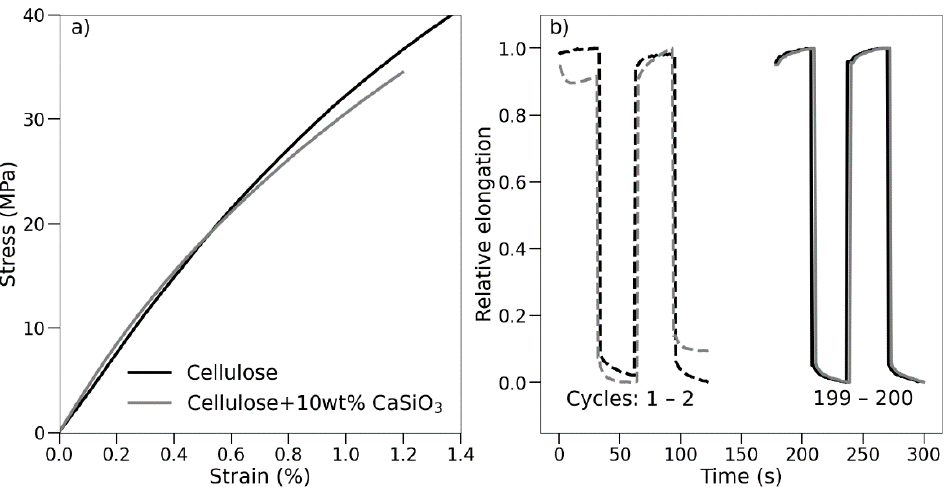
Figure 5. Static mechanical analyses of a cellulose film ( black ) and cellulose – CaSiO 3 composite ( grey ). ( a ): stress-strain curves at 25 °C. ( b ): Creep cycles showing the relative elongation of the films in the first two cycles on the left ( dashed ) and in the last two ones on the right ( solid ).